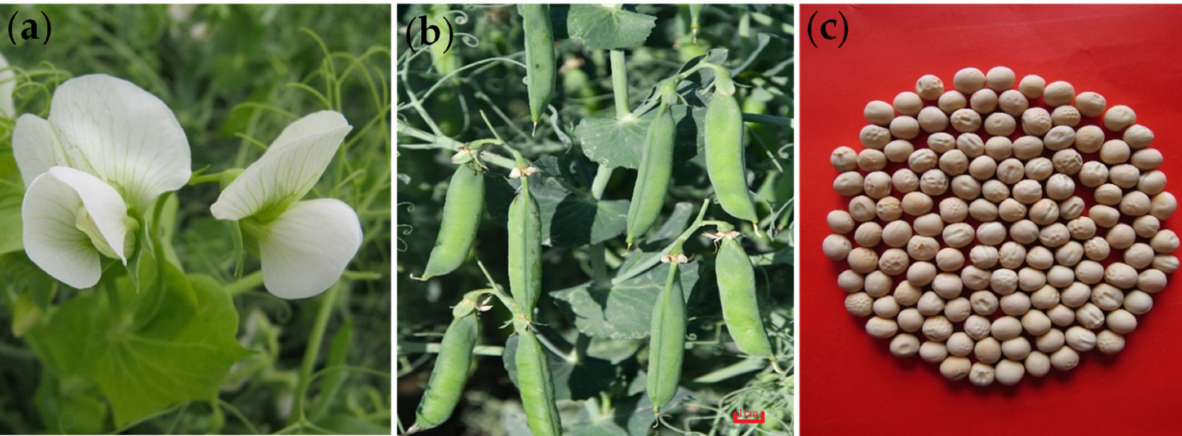
Figure 4. Characteristics of the flower, pod, and grain of Longwan No. 6; ( a ) is the flower of Longwan No. 6; ( b ) is the green pod of Longwan No. 6; and ( c ) is the dry grain of Longwan No. 6.